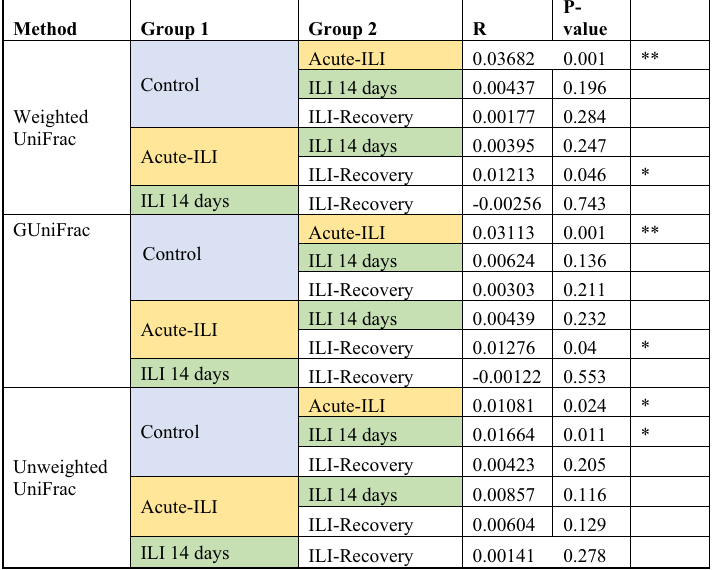
Table 2. Pairwise comparisons of community dissimilarity between the groups. Analysis of similarity (ANOSIM) comparisons were based on weighted, generalized and unweighted UniFrac